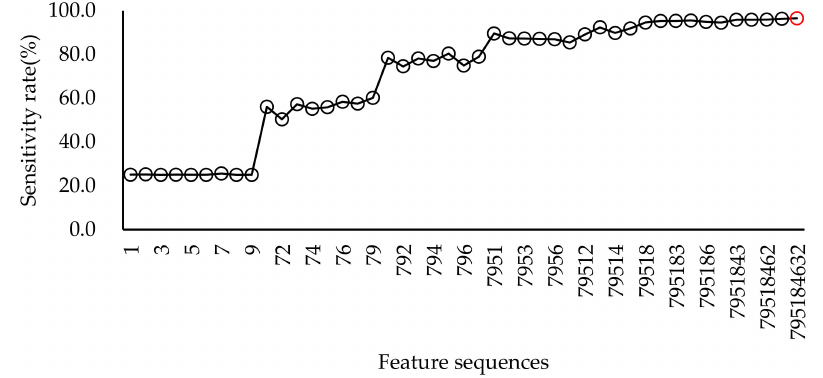
Figure 5. The plot of sensitivity rate in di ff erent feature sequential selection. The red circle marks the maximum recognition